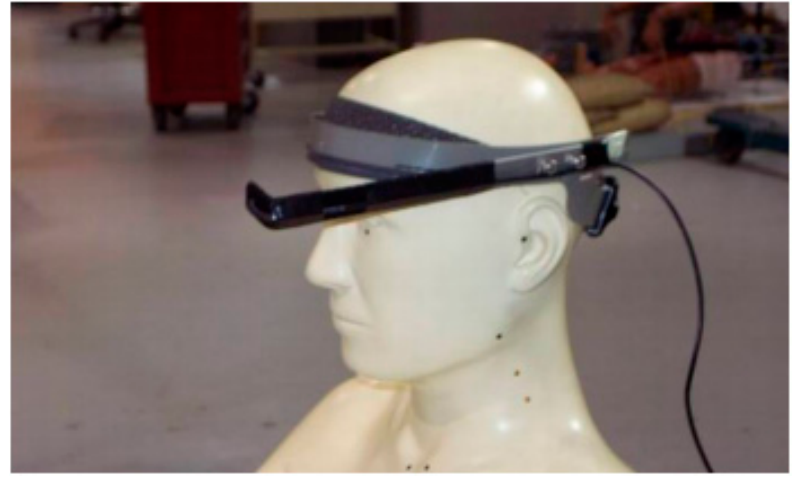
Figure 3. Head-mounted Detection-Response Task (HDRT) set-up [23].